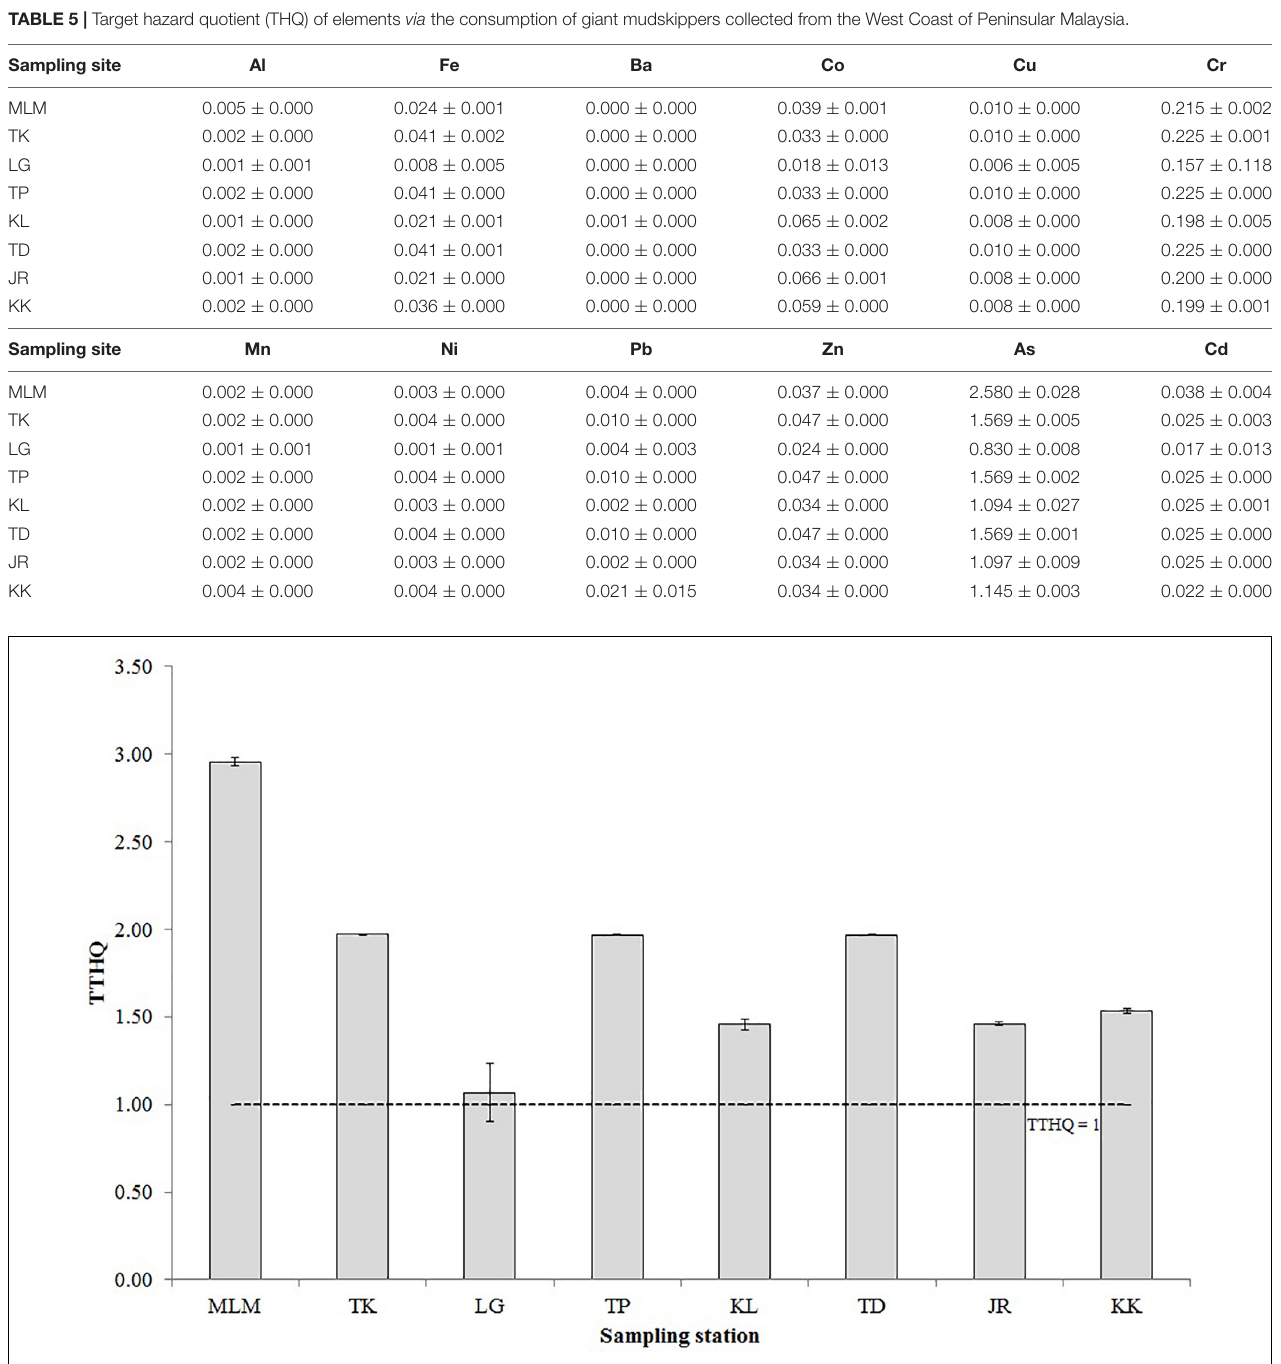
FIGURE 3 | The total target hazard quotient (TTHQ) of elements via the consumption of giant mudskippers. The dotted line marks the TTHQ value of 1. TTHQ < 1 indicates that the population is not expected to experience non-cancer risks; TTHQ > 1 indicates that further evaluation is recommended.